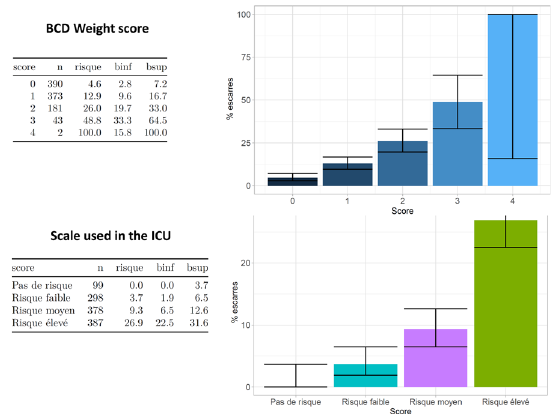
Fig. 1 Comparison of a score specific of the ICU with usual scale for the acquisition of